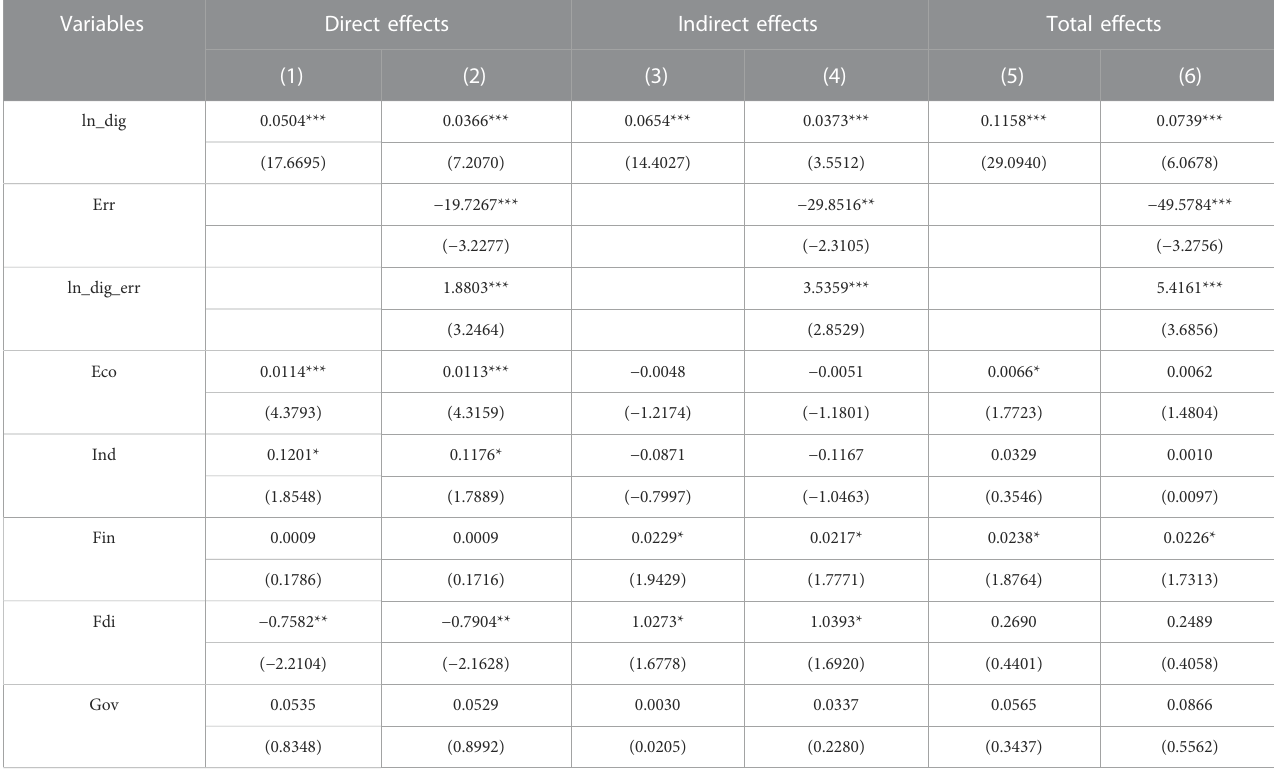
TABLE 7 Direct, indirect and total